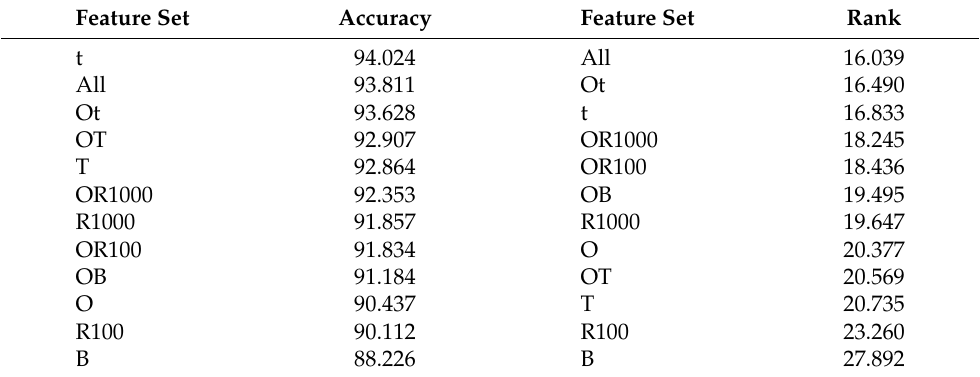
Table 5. Average accuracies and ranks for each feature set, from all the datasets. For each feature set, the values in these tables are the averages for RF, SVM-L, and SVM-G in Table